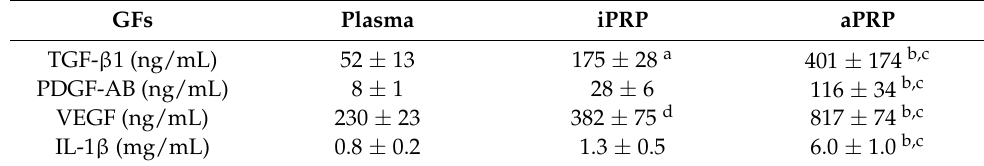
Scheff é post hoc multiple comparison test: a , iPRP versus plasma ( p < 0.05); b , aPRP versus plasma ( p < 0.0005); c , aPRP versus iPRP ( p < 0.0005); d , iPRP versus plasma ( p <